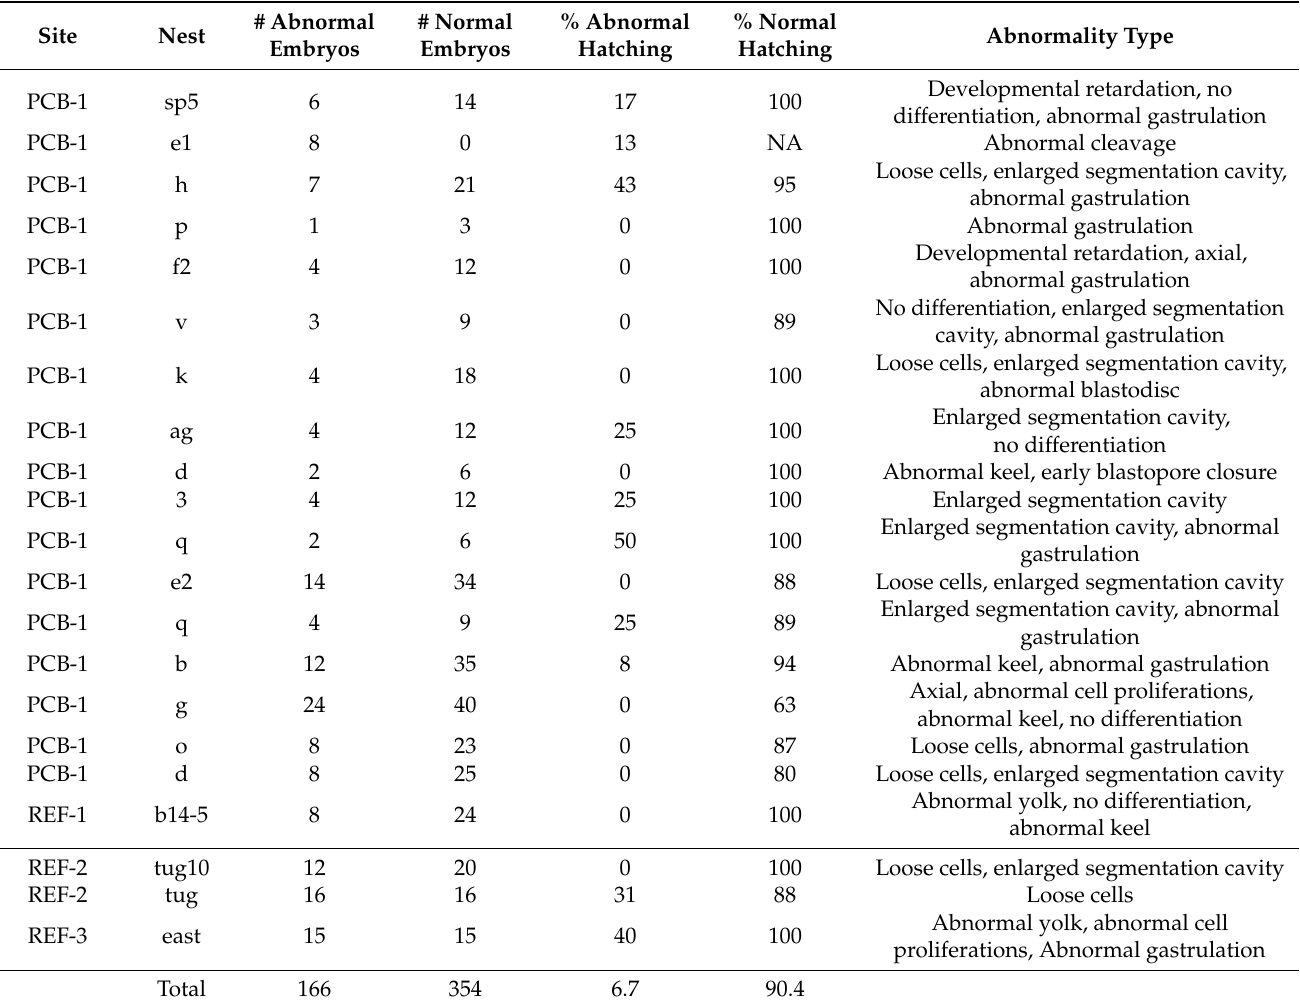
Table 2. Types and frequency of abnormal embryos that were used in the embryo incubations. Survival or the % of abnormal embryos hatching is compared to normal embryos found within the same